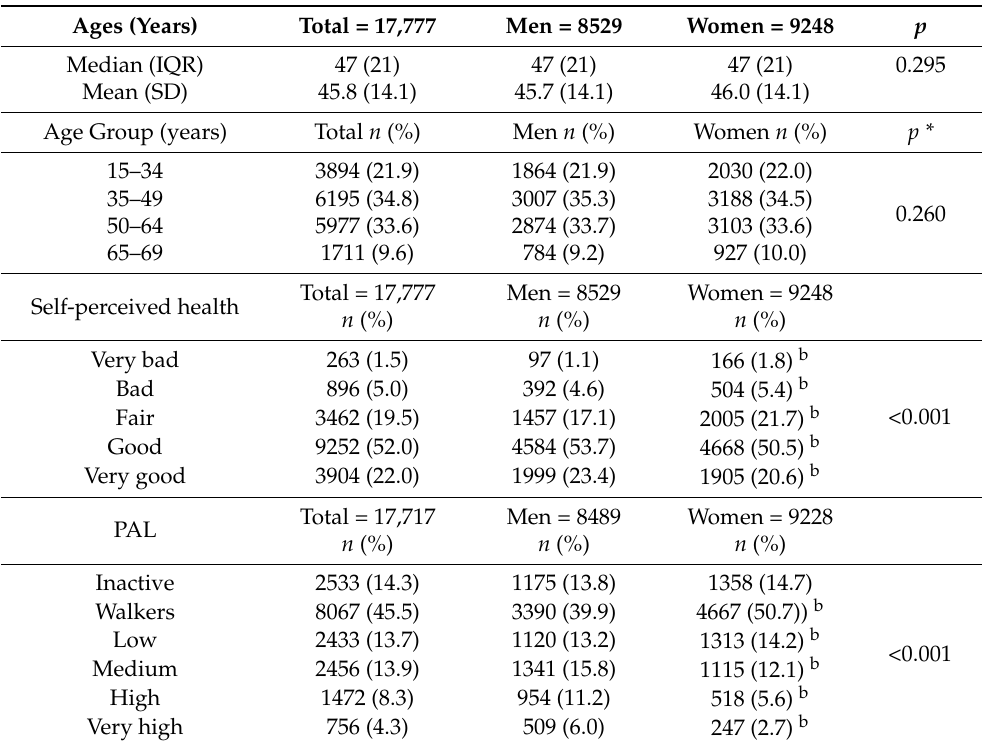
Table 1. Socio-demographic characteristics, self-perceived health, and the level of physical activity in the Spanish population through the ENSE